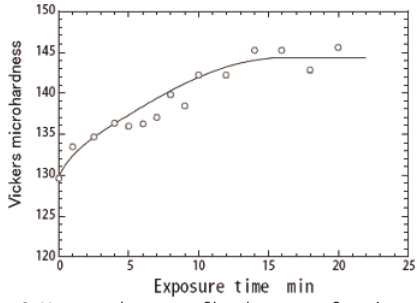
Fig. 2. Measured course of hardness as a function of the exposure time to cavitation